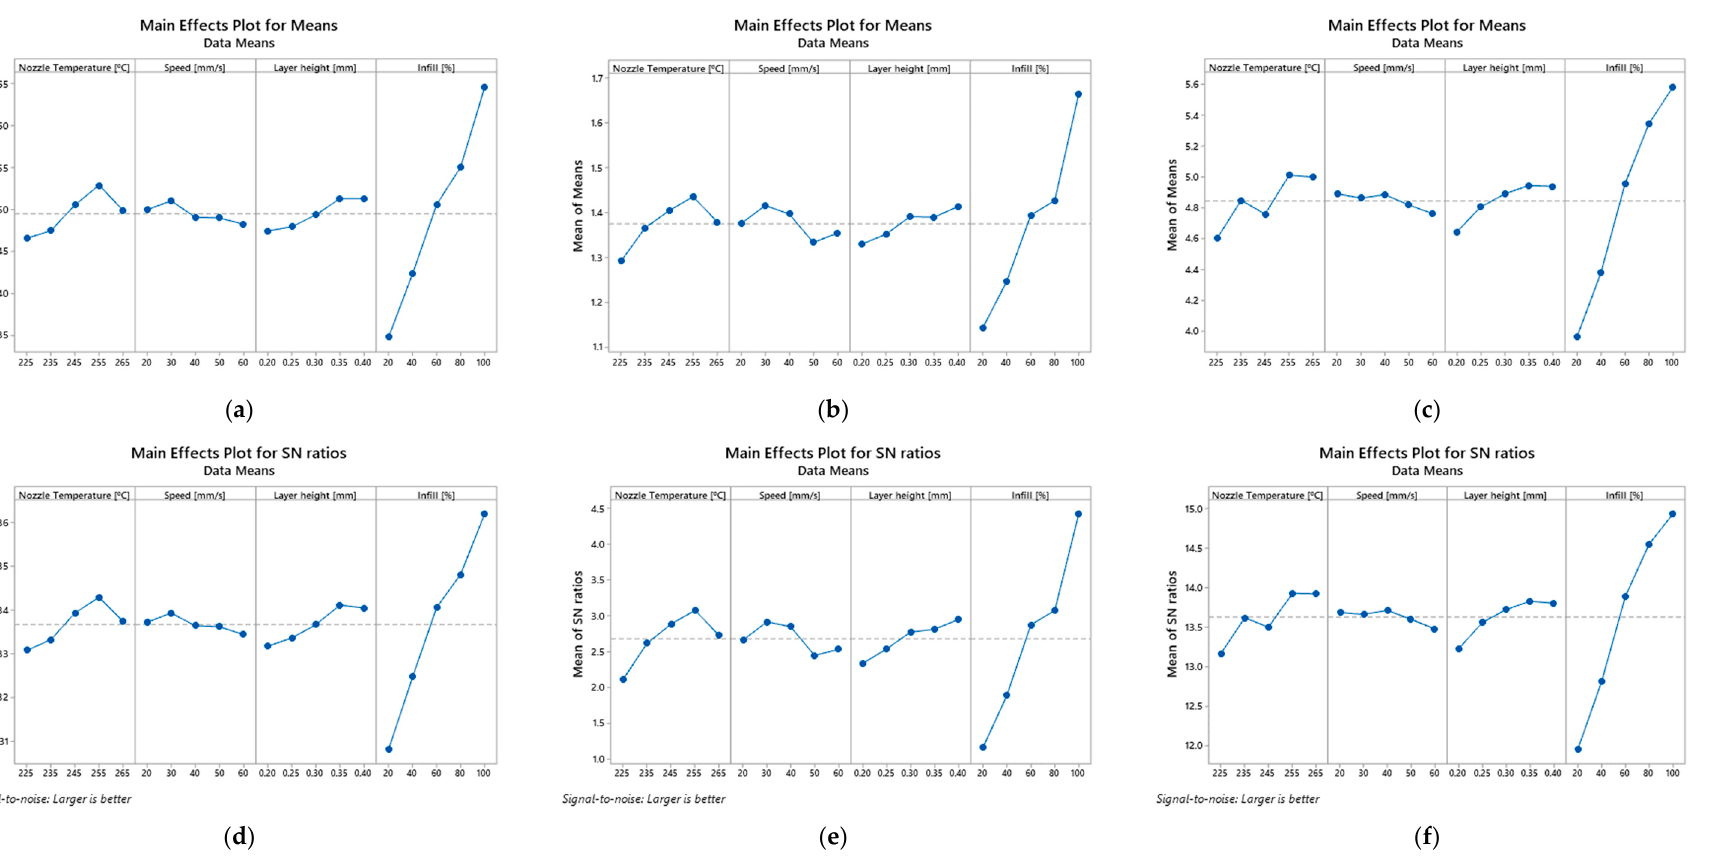
Figure 3. Main effect plot for means of: ( a ) bending stress, ( b ) bending modulus, ( c ) bending strain, and main effect plot for means of S/N ratios of: ( d ) bending stress, ( e ) bending modulus, ( f ) bending strain for PETG samples.